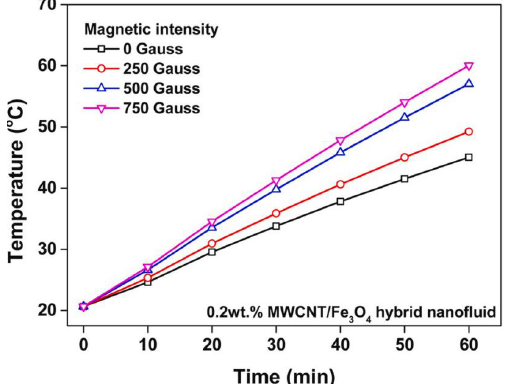
Figure 16. Variation of temperature with time for the 0.2 wt% MWCNT/Fe 3 O 4 hybrid nanofluid under different magnetic intensities [41]; 2020, Elsevier.